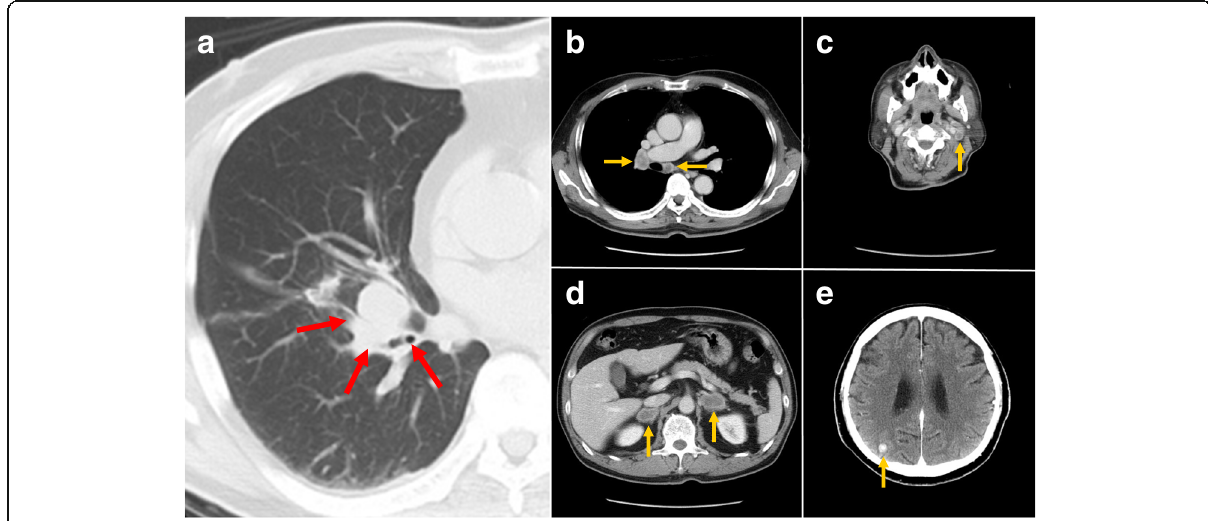
Fig. 1 Far-advanced lung cancer on CT survey. a A primary lung tumor (red arrows) was located in the right middle lobe. Metastatic nodules (yellow arrows) were noted in the b lymph nodes at the hilum of the right lung and lymph nodes at the bifurcation of the trachea and c lymph nodes at the left side of the neck, d bilateral adrenal glands, and e brain